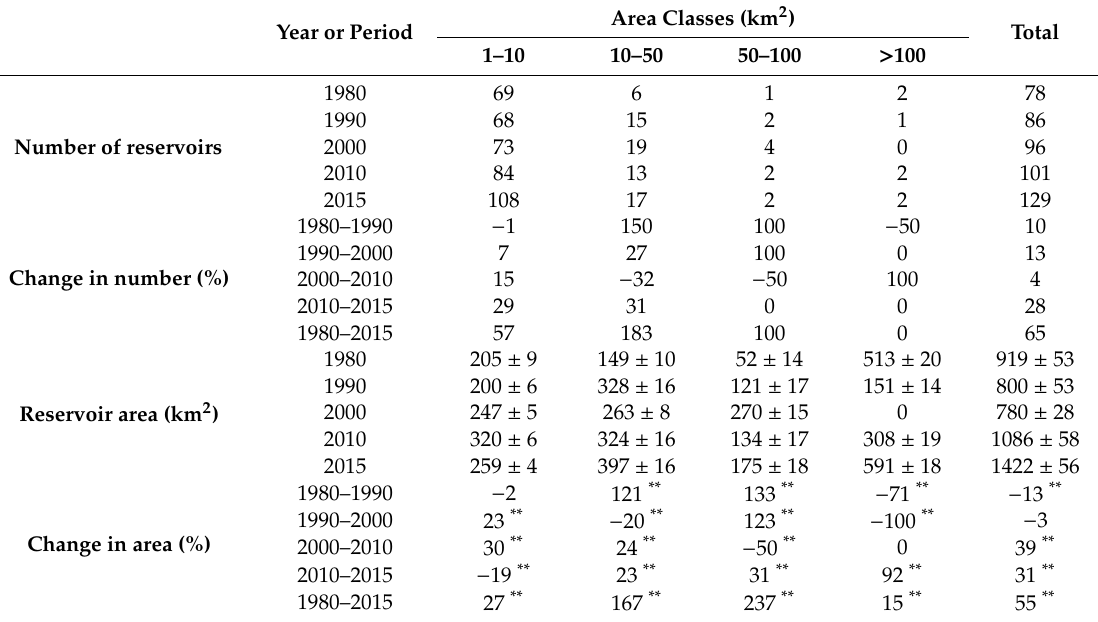
Table 4. Reservoir number, area, and changes in di ff erent classes between 1980 and